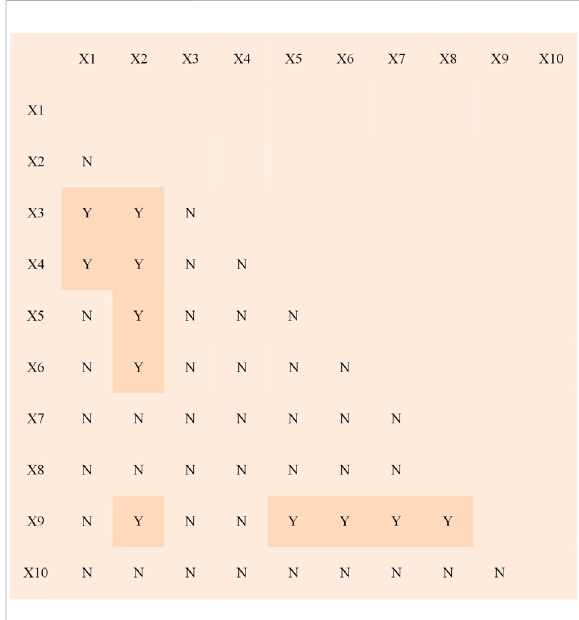
FIGURE 7 Statistical signi fi cance of detection factors (con fi dence level 95%). Note: Y indicates that there is signi fi cant difference (95% con fi dence) between the two factors on NDVI; N indicates no signi fi cant difference.